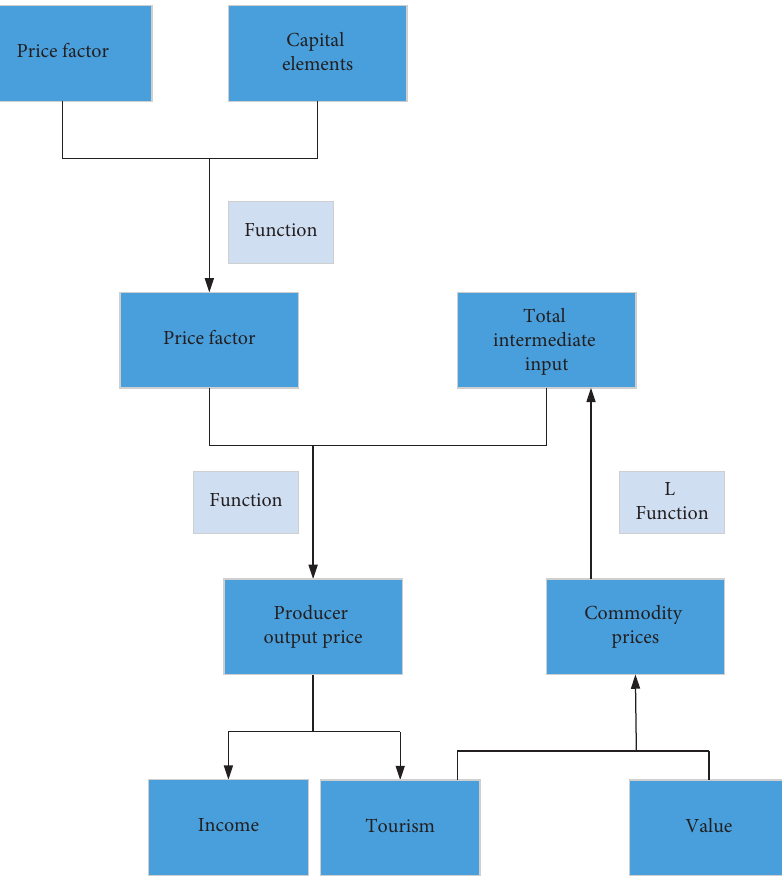
Figure 8: CGE model